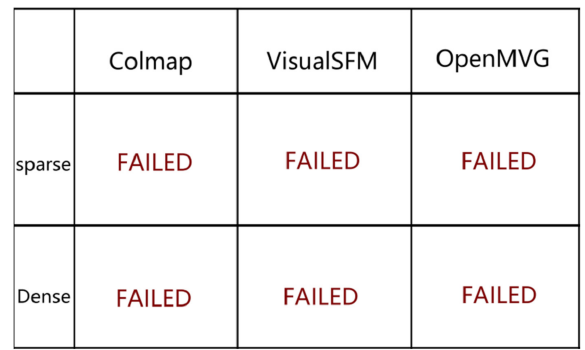
Figure 20. The results of experiment 2.